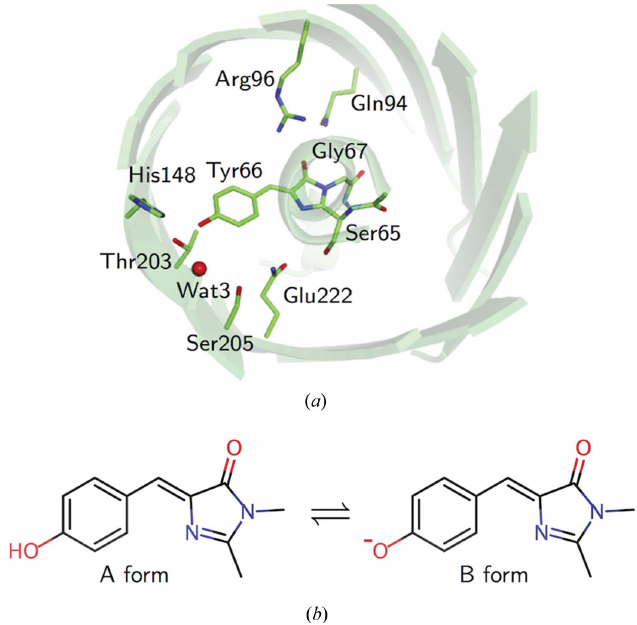
Figure 1 The structure of GFP from A. victoria . ( a ) The GFP structure as viewed from the top of the (cid:3) -barrel, showing the chromophore and the interacting residues. The residue names are shown for wild-type GFP, while the structure of the E222Q variant determined in this research is used as the model. ( b ) The dual protonation states of the